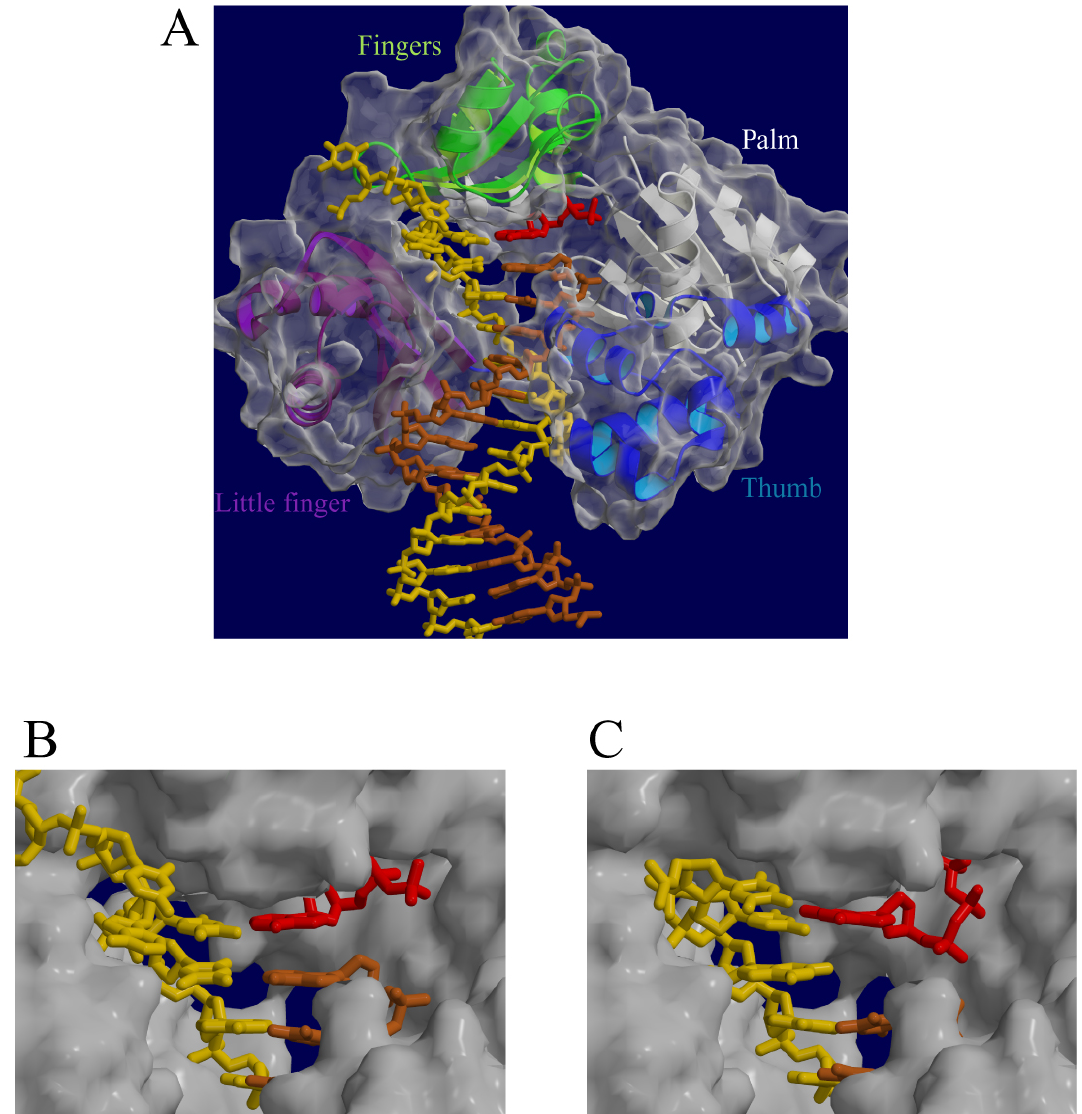
FIGURE 1. A: Ternary complex of Sulfolobus sulfataricus Dpo4 complexed with a DNA template-primer (yellow and brown, respectively) and an incoming nucleotide (red). A transparent molecular surface representation of the enzyme shows that the fingers and thumb domains are exceptionally small when compared to other DNA polymerases, thus configuring an extremely open nascent basepair binding pocket[64]. The nascent basepair binding pocket is able to accommodate a correct basepair (B) as well as a misaligned template primer (C). The figure was made with Molscript[80] and GRASP[81] and rendered with